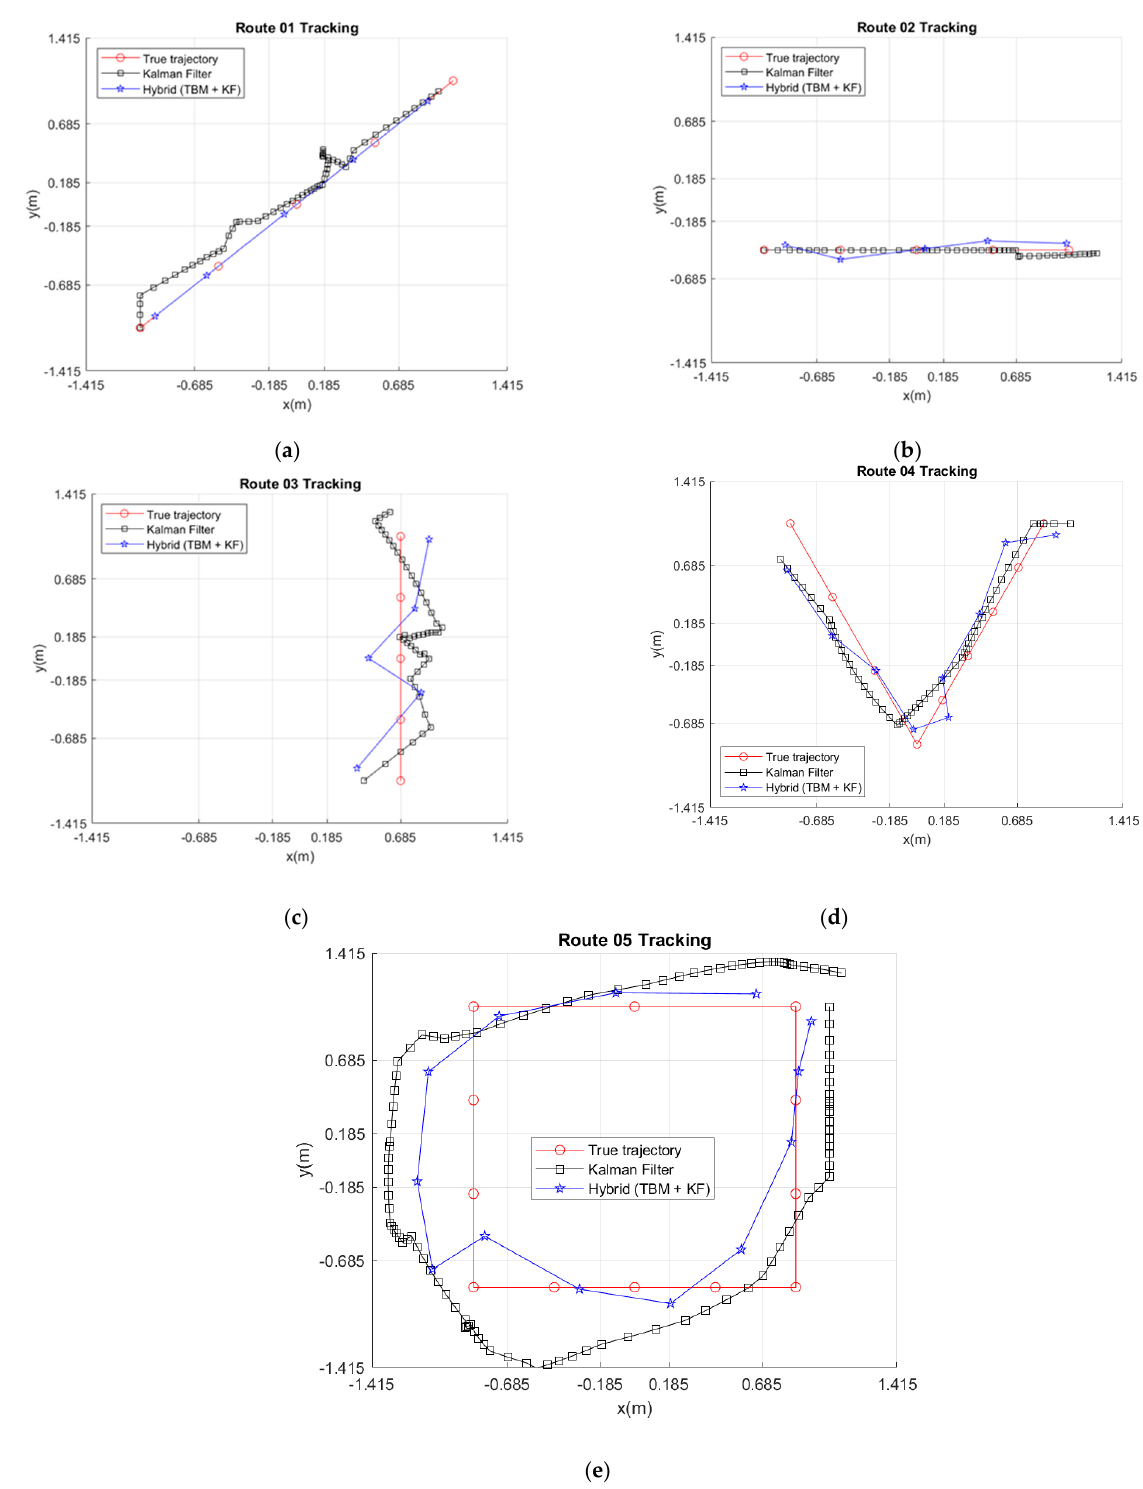
Figure 10. Typical examples of tracking results with the hybrid approach and Kalman filter: ( a ) Route 01, ( b ) Route 02, ( c ) Route 03, ( d ) Route 04, and ( e ) Route 05.